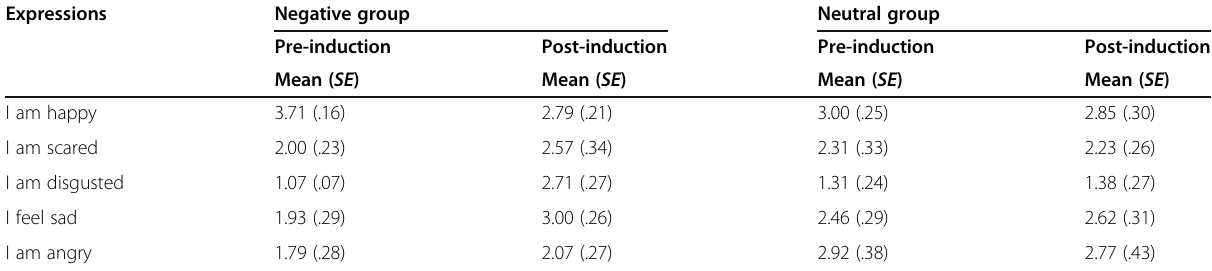
Table 2 The mean scores of participants for the evaluation of expressions in each group